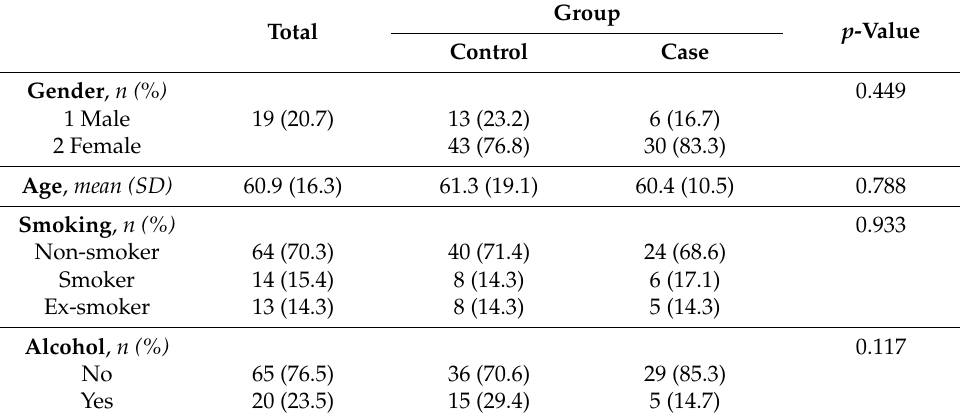
Table 1. Description and comparison of demographic variables and habits of the two study. Group p -Value Total Control Case Gender , n ( % )